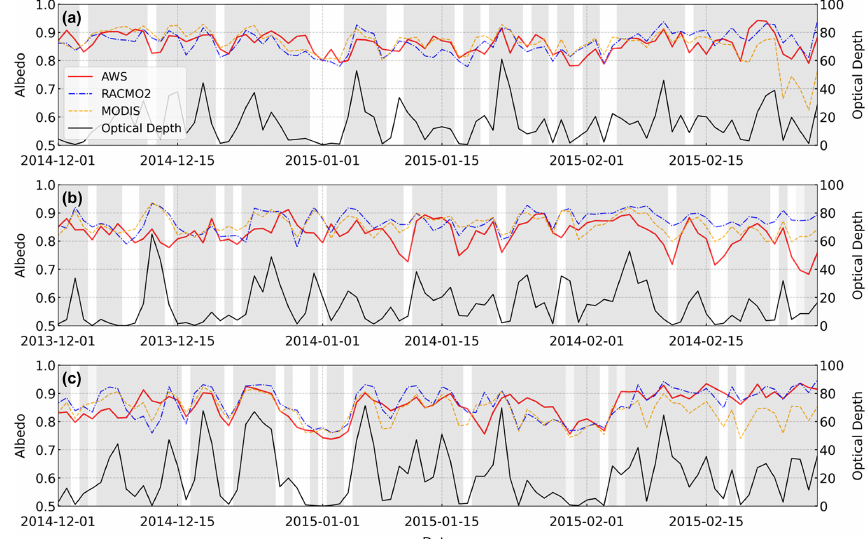
Figure 7. Temporal changes in albedo from the regional atmospheric climate model version 2.3p2 (RACMO2) simulations, automatic weather station (AWS) observations, and Moderate Resolution Imaging Spectroradiometer (MODIS) observations at AWS 14, AWS 17, and AWS 18 during the austral summer 2014–2015, 2013–2014, and 2014–2015, respectively. The gray bars indicate the binary cloudiness of a 500 × 500 MODIS pixel corresponding to each AWS